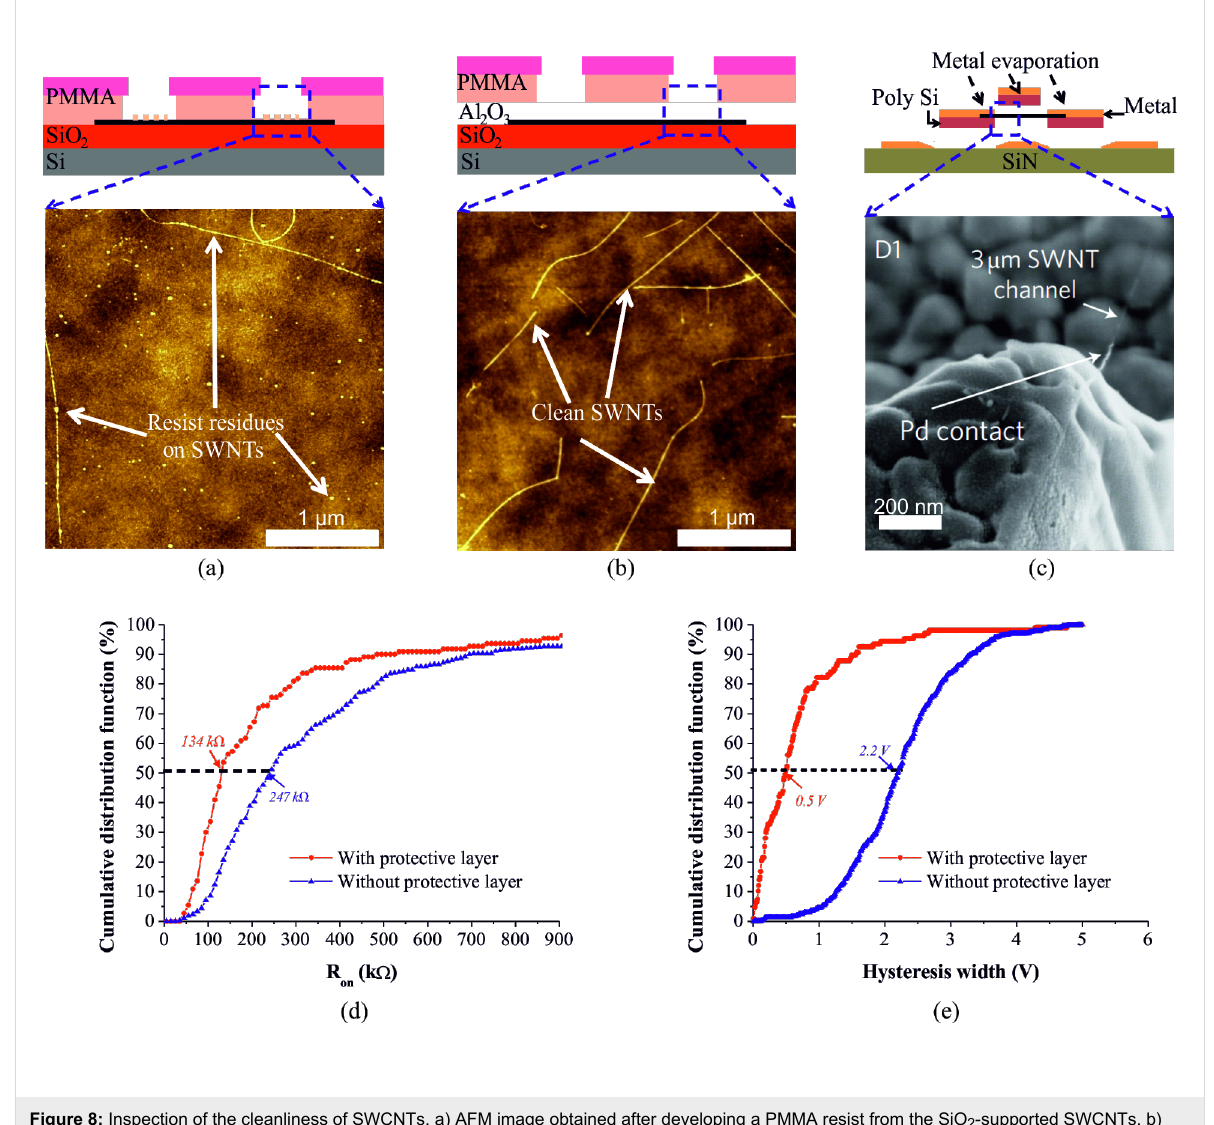
Figure 8: Inspection of the cleanliness of SWCNTs. a) AFM image obtained after developing a PMMA resist from the SiO 2 -supported SWCNTs. b) AFM image obtained after PMMA and following alumina removal from the contact area. c) SEM image of a Pd contact on a suspended SWCNT using a shadow mask process. d) The cumulative distribution function of on-resistance for n-type CNFETs. Red circles and blue triangles represent the experimental results with and without using the protective layer, respectively. e) The distribution of the hysteresis width for n-type CNFETs. Figure reprinted with permission from (c) [53] copyright 2010 Macmillan Publisher and (d,e) [71] copyright 2014